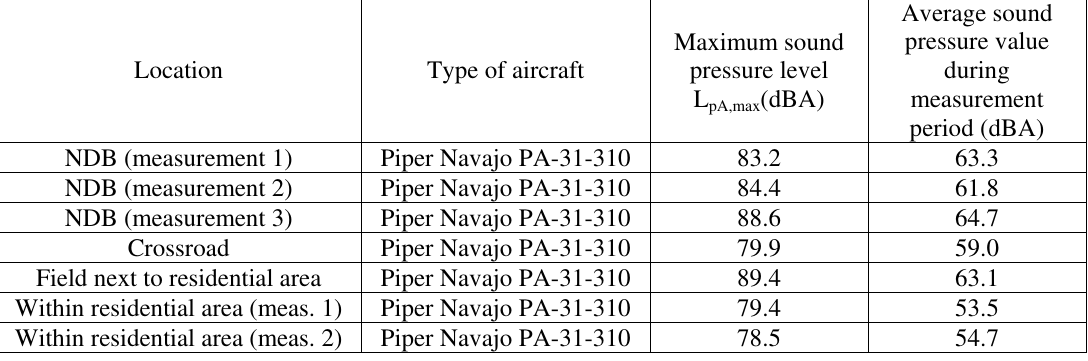
Table 3. Maximum corrected noise levels